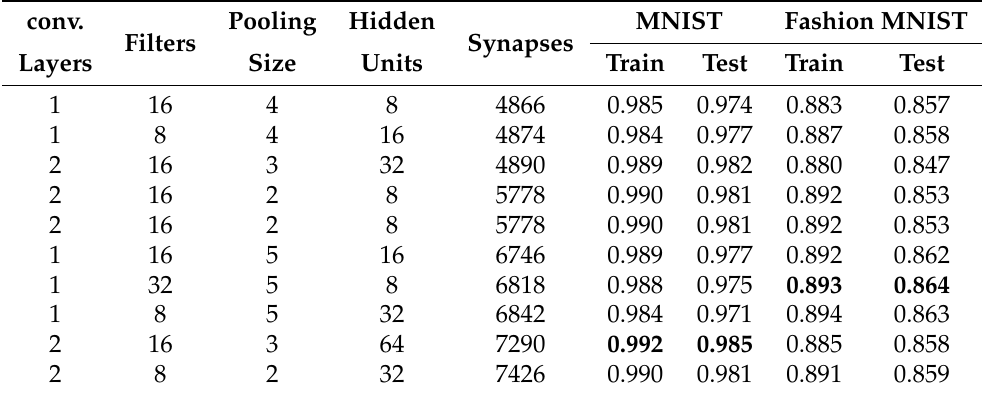
Table 7. Top 10 architectures for CNN with a number of synapses in between 4096 and 8192.